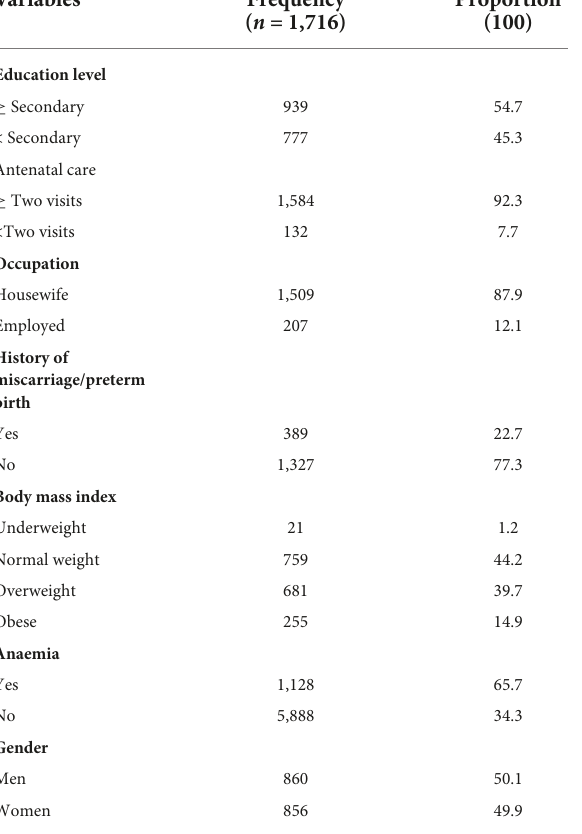
TABLE 1 Frequency and proportion of pregnant women in Khartoum, Sudan, 2020.